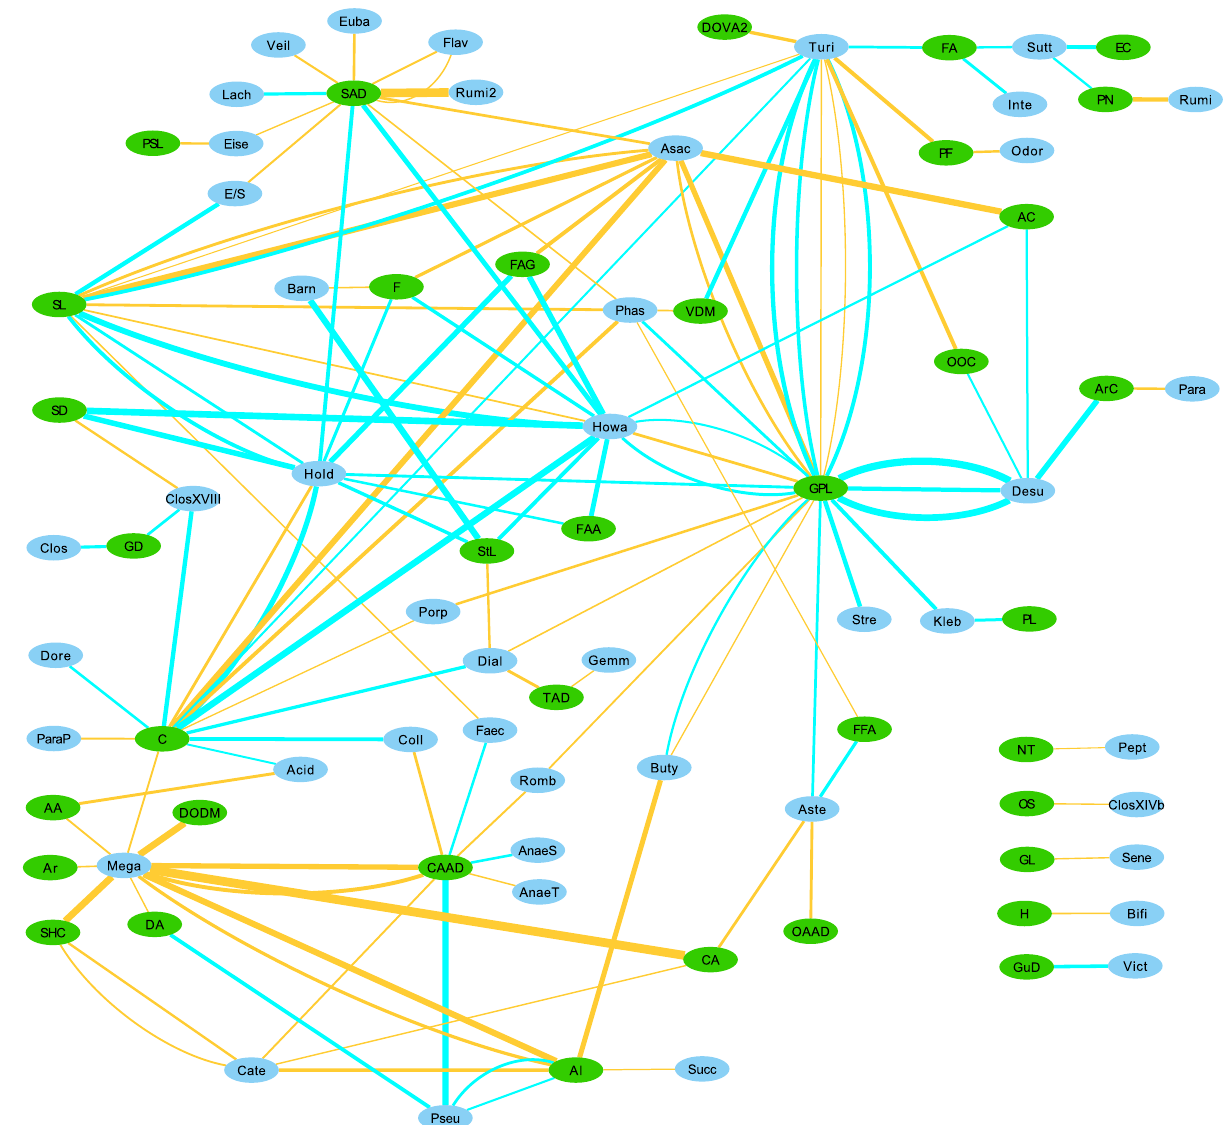
Fig. 2 Network of within-Controls ’ correlations. Network of within-Controls ’ correlations between bacterial genera and metabolite classes. Supplementary Tables 1 and 2 contain correlations with bins composed of more than one genus (or higher taxon) which were unclassi fi ed at genus level, but these bins were removed from Figs. 1 and 2 to aid in visualization and to focus on the identi fi ed genera. Edge thickness represents the strength of the correlation. Blue edges represent positive correlations, and Orange edges represent negative correlations. Green nodes represent metabolite classes and may contain more than one metabolite feature (hence why there may be multiple edges between two nodes), and Cyan nodes represent bacterial genera. Check Table 6 at the end of this article for the key to the abbreviations used in Figs. 1 and